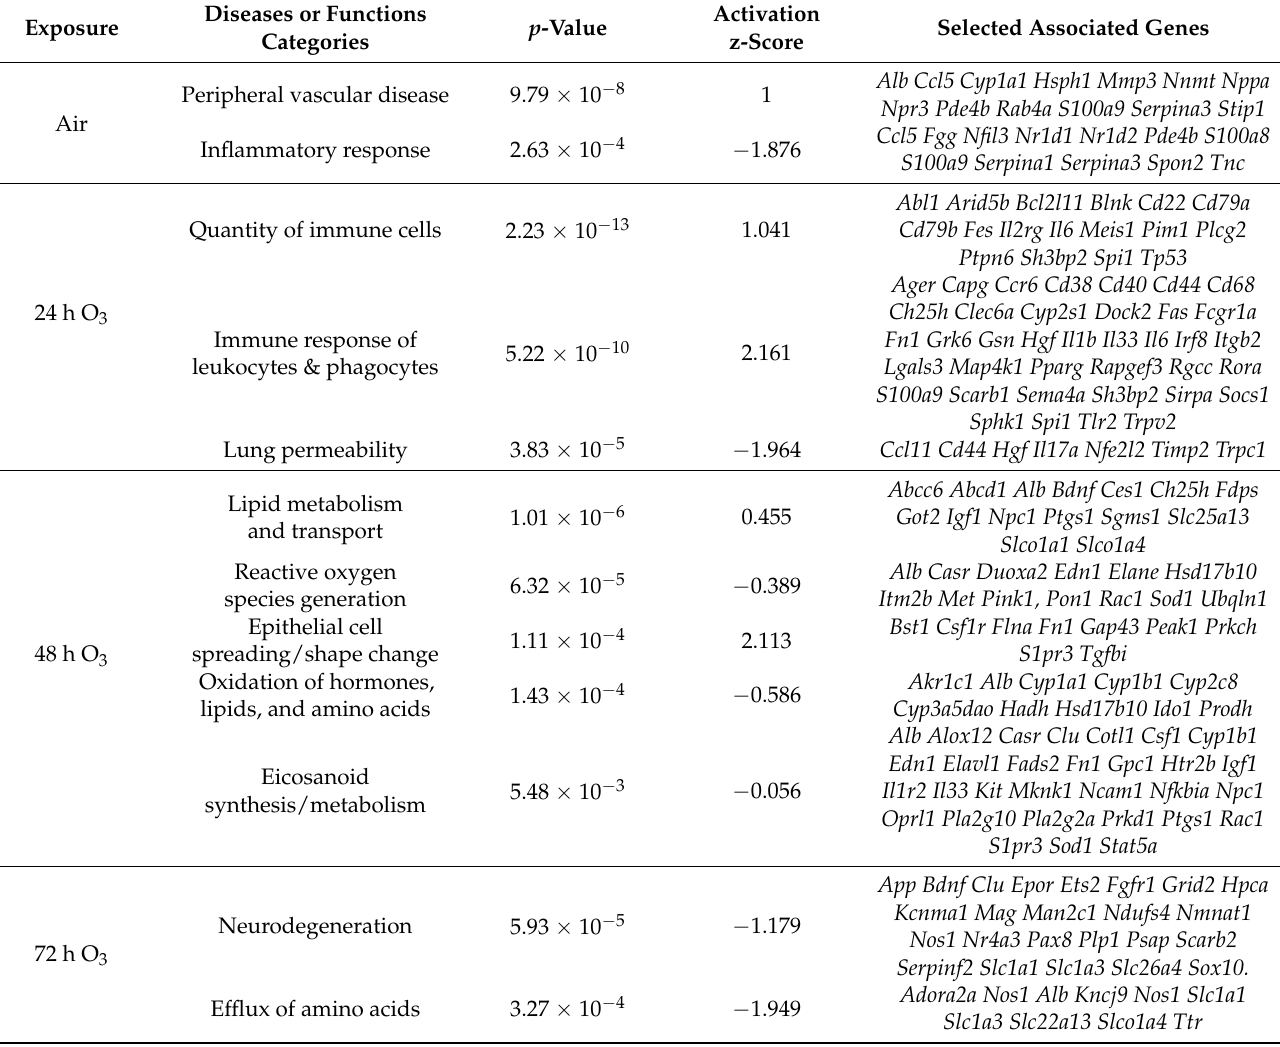
Table 3. Representative diseases and biological functions predicted to be affected by tumor necrosis factor receptor (TNFR)-dependent lung transcriptome changes in mice determined by Ingenuity Pathway Analysis